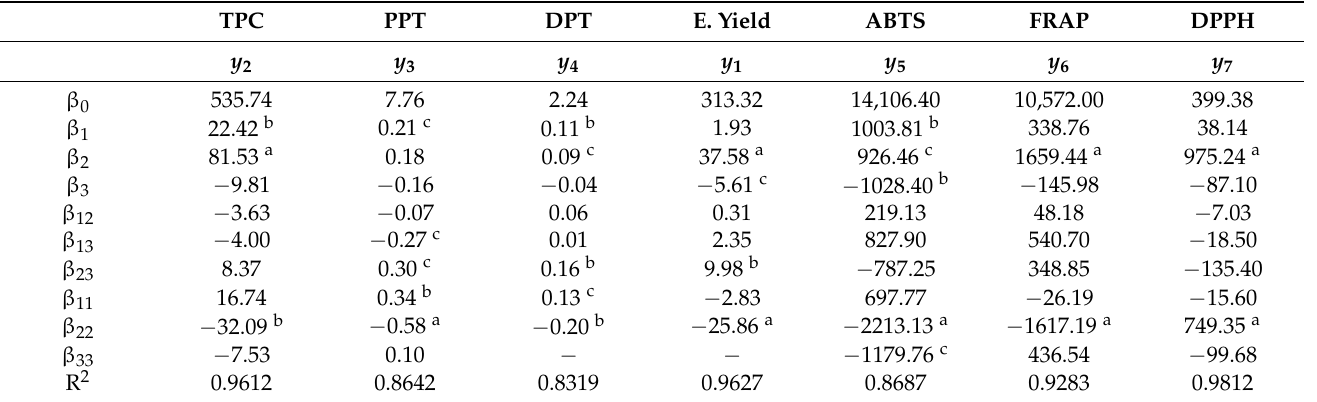
Table 3. Regression coefficients and statistical parameters measuring the correlation and significance of the